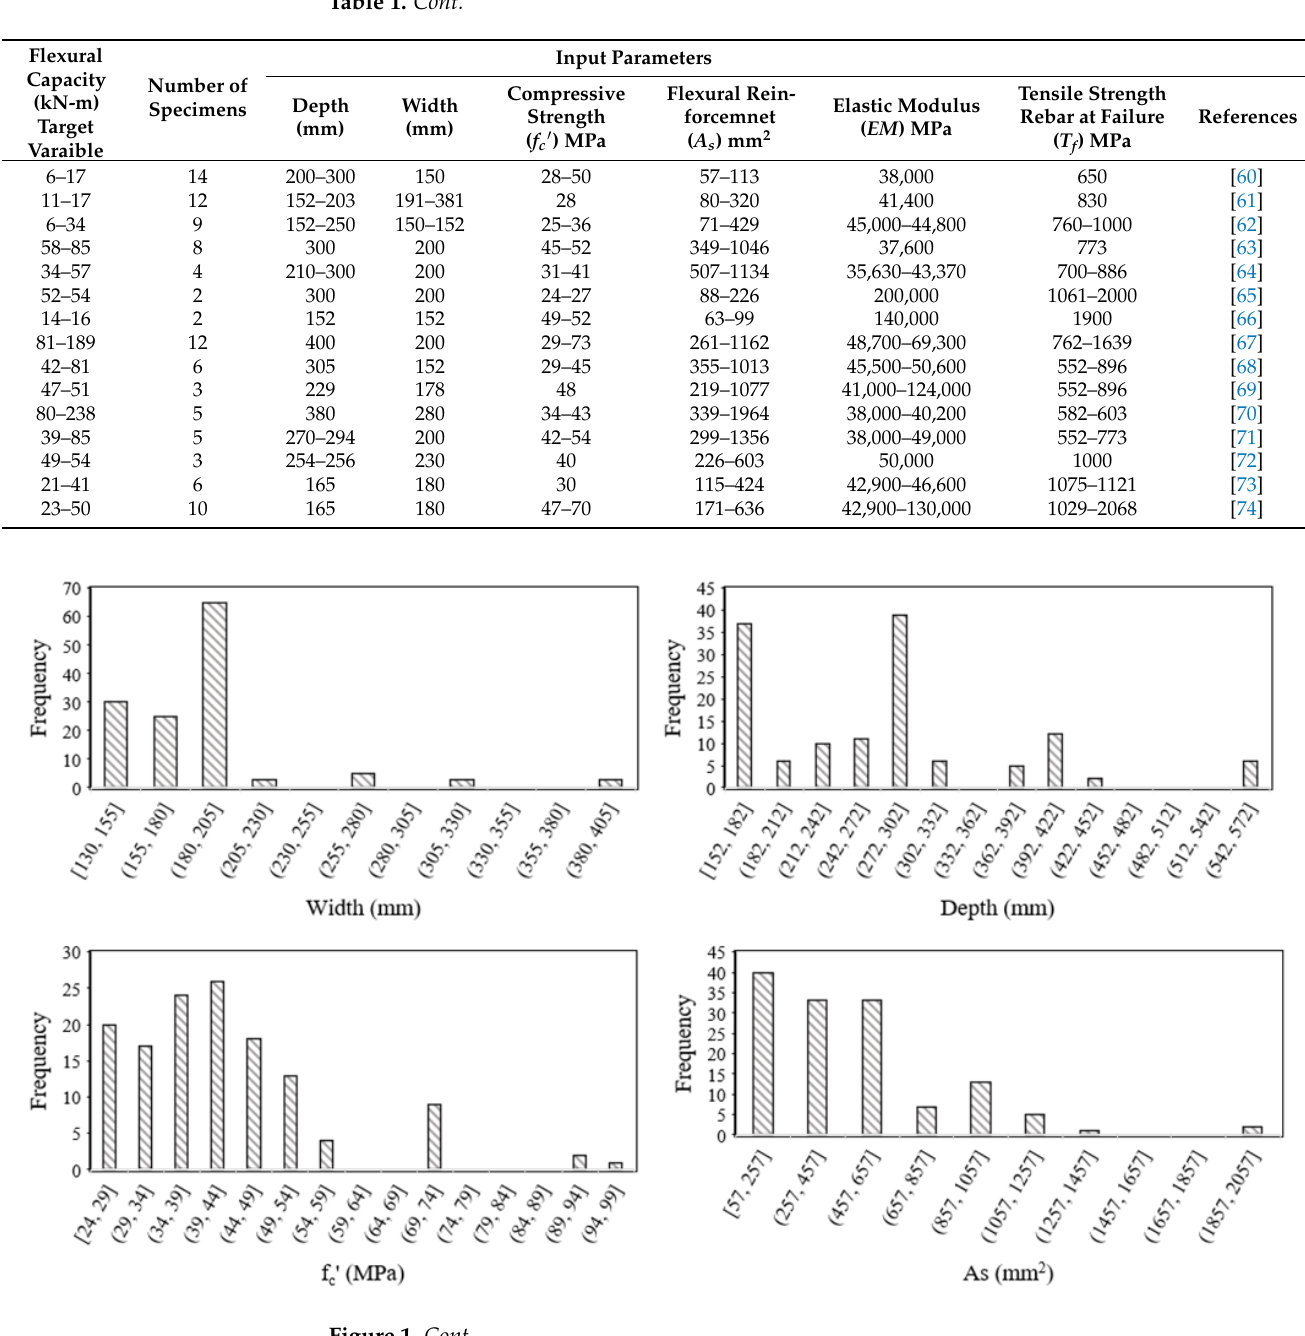
1 Figure 1. Distribution histograms of the variables ( W , D , f c ’ , As , EM , T f , M ) used in the development of models.